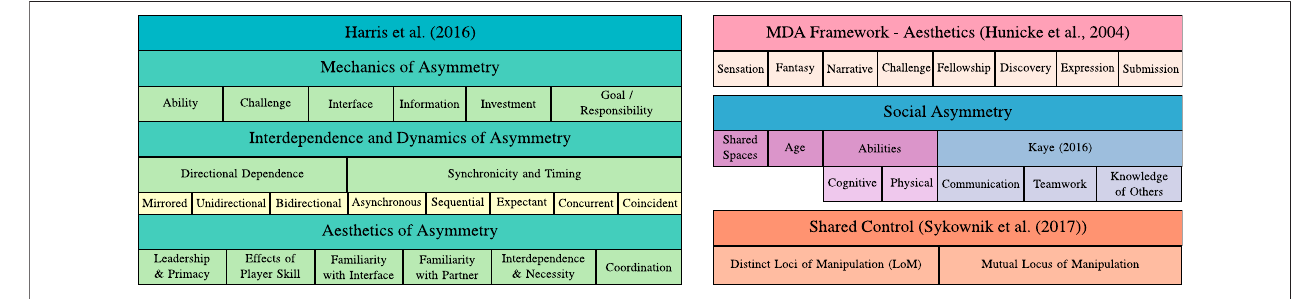
FIGURE 2 | Our a priori “ best fi t ” framework for asymmetric VR